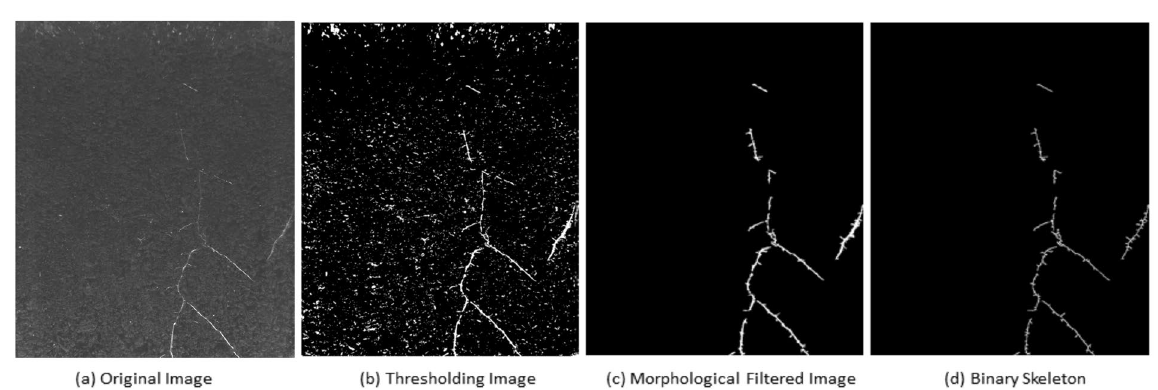
Figure 3. Basic steps of root image processing and analysis in saRIA: ( a ) Arabidopsis soil-root image, ( b ) adaptive thresholding, ( c ) morphological filtering, ( d ) root